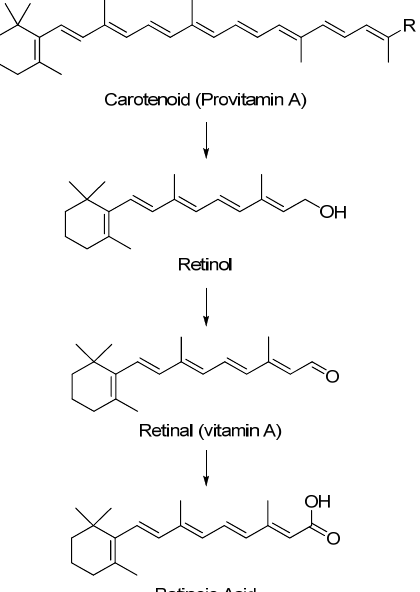
Figure 3. Biotransformation of structurally-relevant carotenoids to vitamin A and related